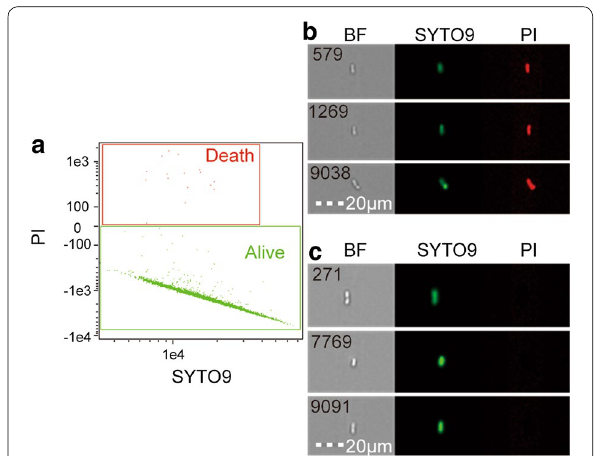
Fig. 2 Live and dead B. mucilaginous based on multispectral imaging flow. a From the collected images, live and dead B. mucilaginous and dust were visually identified (as indicated by colored crosses) and the tagged populations were gated on the original plot. b Images of dead B. mucilaginous in the fermented liquid. c Images of live B. mucilaginous in the fermented liquid. Images from within each region were chosen at random. From left to right, bright-field, SYTO 9, and propidium iodide channel images are